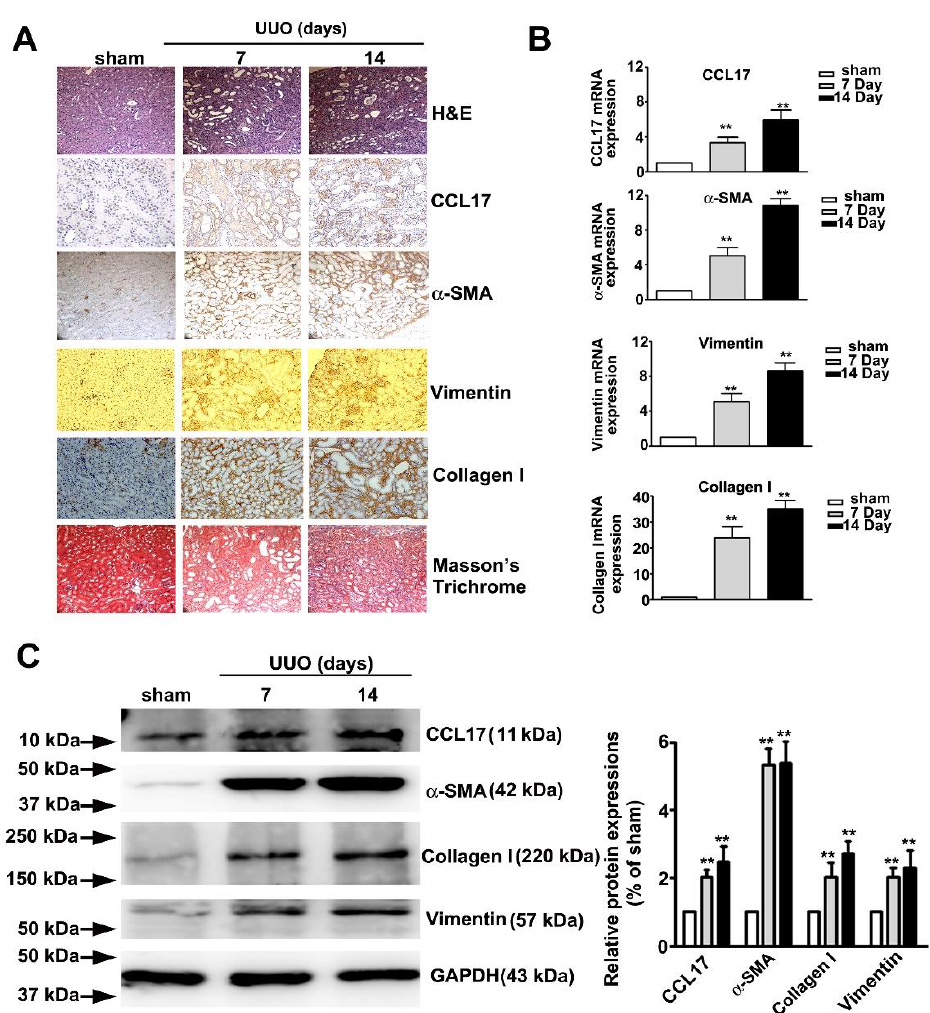
Figure 5. Expression of CCL17 and the morphological transformation of renal tissues in UUO mice. ( A ) Kidney tissue of C57BL/6 mice with unilateral ureteral obstruction (UUO) for 7 and 14 days visualized by hematoxylin and eosin (H&E) stain, immunohistochemical stain (CCL-17, α-SMA, and vimentin), and Masson’s Trichrome staining; ( B ) qRTPCR and ( C ) western blot of mRNA and protein expressions of CCL17, collagen I, α-SMA, and vimentin in sham surgery and UUO mice. GAPDH was used to normalize mRNA loading. Results are expressed as the mean ± SD of at least three independent experiments. ** p < 0.01 compared with sham surgery group.